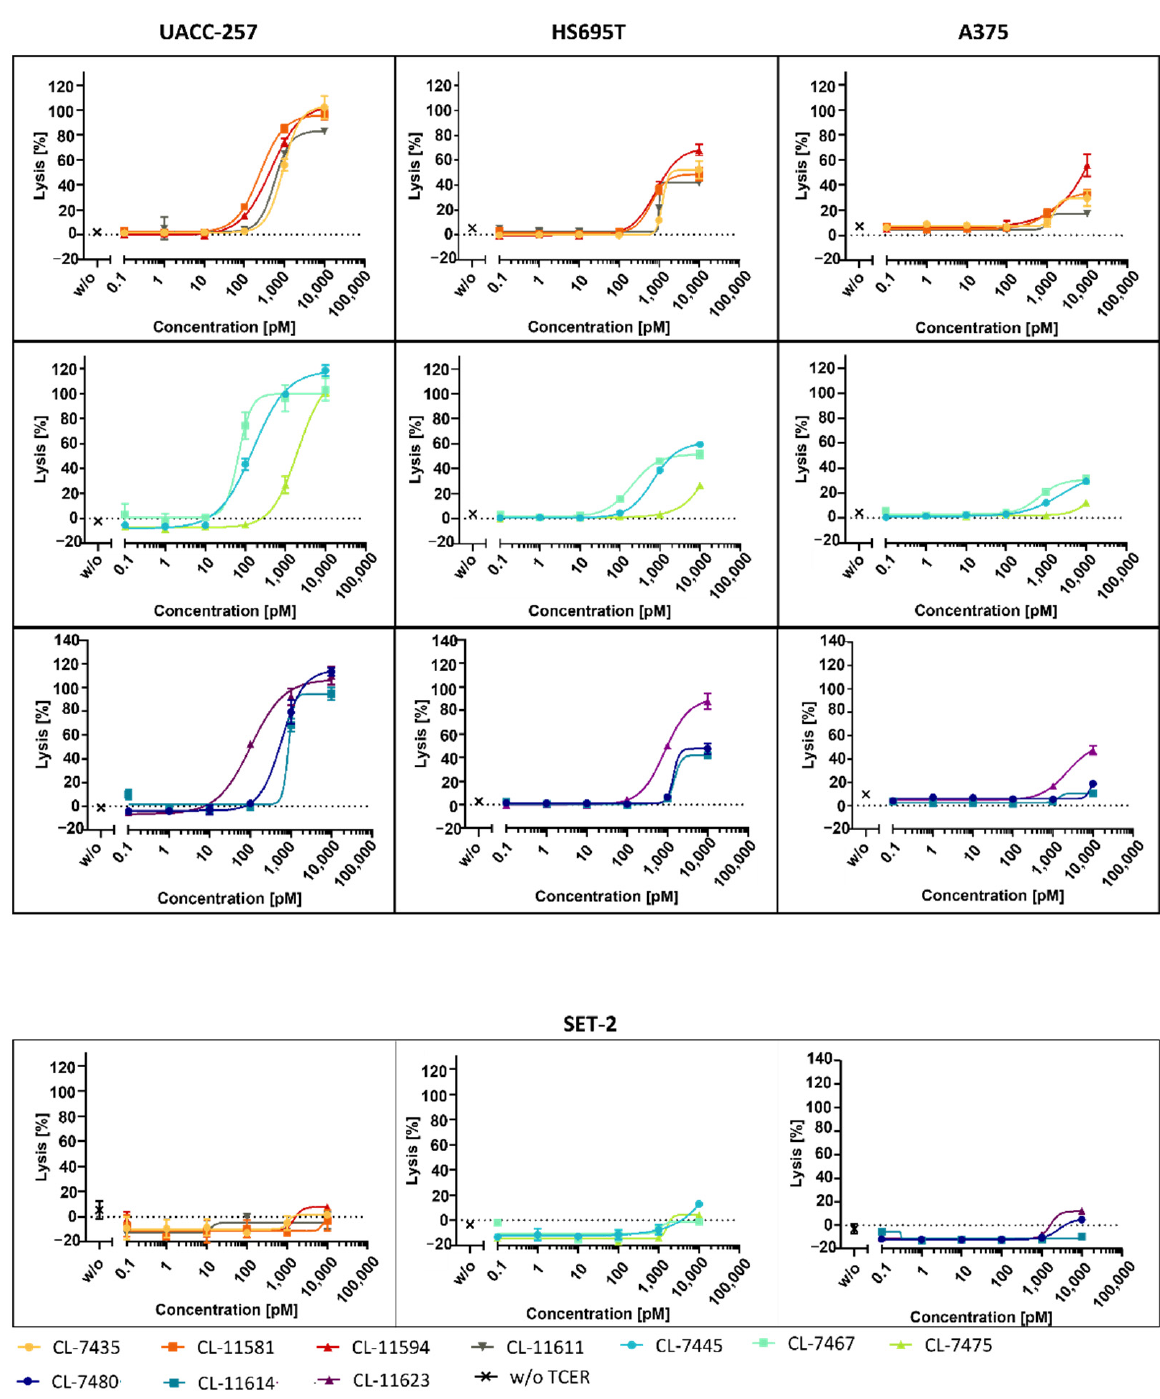
Figure 6. Assessment of tumor cell lysis mediated by the selected TCER candidates. PBMC of a healthy human donor were co-cultured with tumor cells at an effector-to-target ratio of 10:1 and in presence of increasing TCER concentrations. Lysis of PRAME pHLA-positive target cells UACC-257 (1100 cpc), HS695T (400–550 cpc), and A375 (50 cpc) was determined based on LDH-release assay. For control, SET-2 cells were used as a target negative cell line. Each datapoint represents the mean of triplicate measurements with the respective SD. Table 5. EC50 values based on cytotoxicity data from selected candidates.